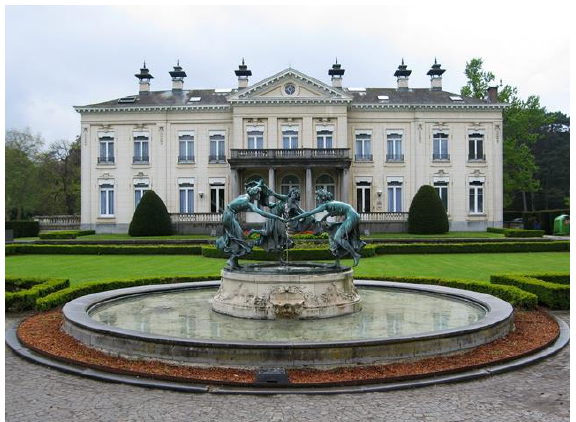
Figure 1. Castle as defined in architectural heritage (Castle Den Brandt, copyright Flanders Heritage).